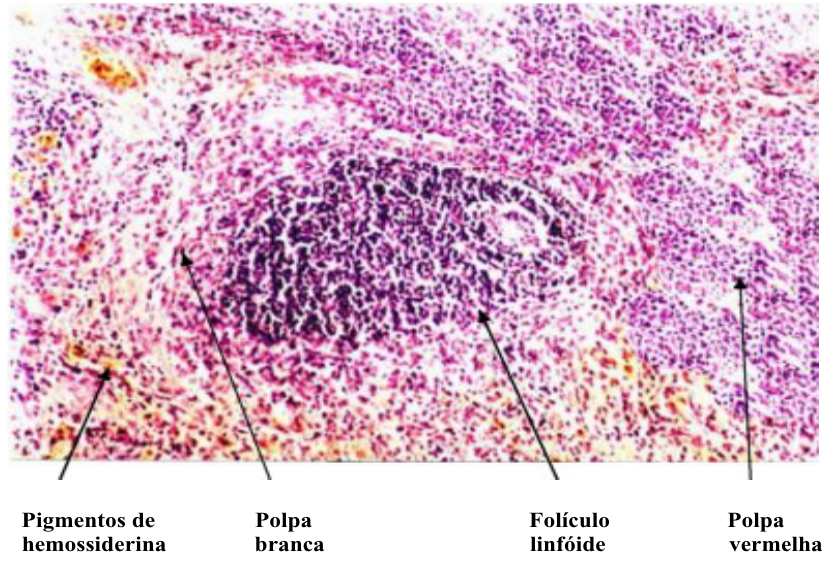
Pigmentos de Polpa Folículo Polpa FIGURA 2 - Morfologia microscópica do auto-implante esplênico regenerado (HE- 20 x)